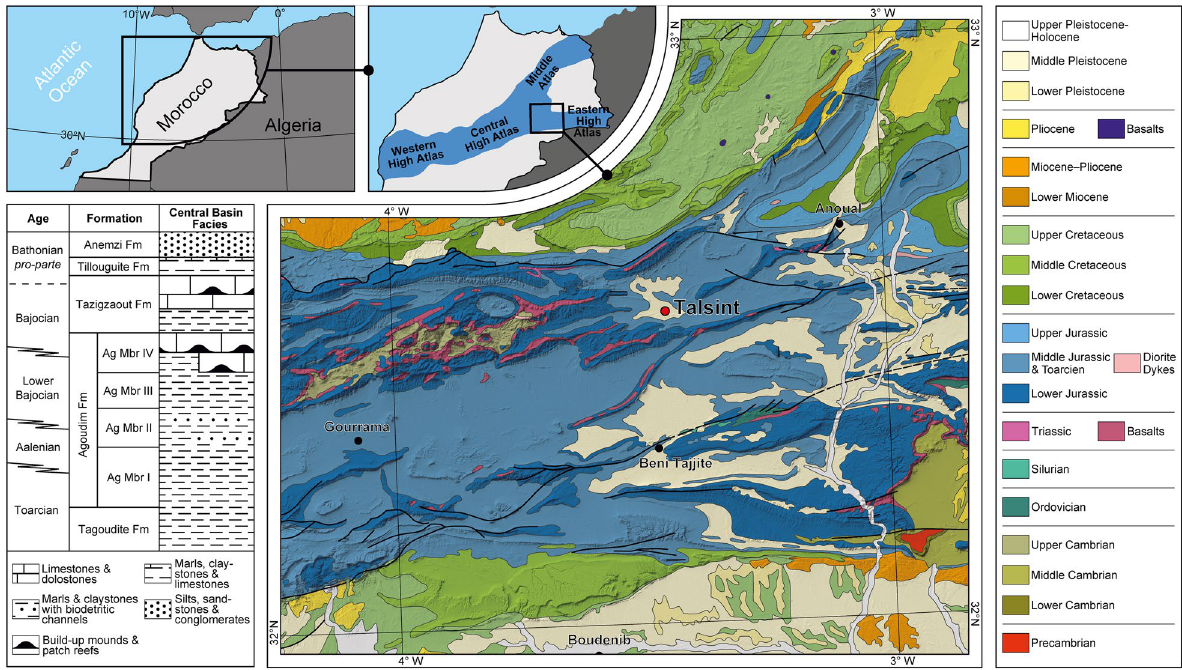
Fig. 1 Geological location map (modified from Saadi et al., 1985 and Ait Addi & Chafiki,